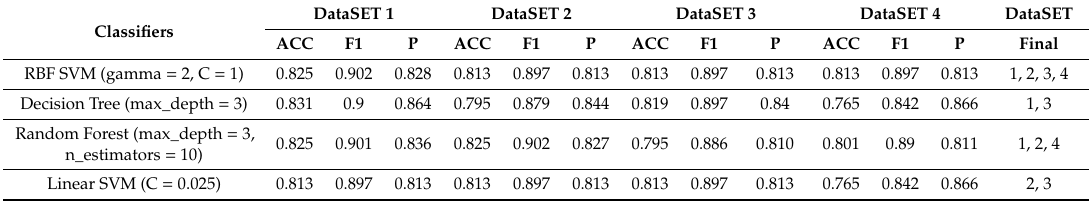
Table 7. Comparison of results.